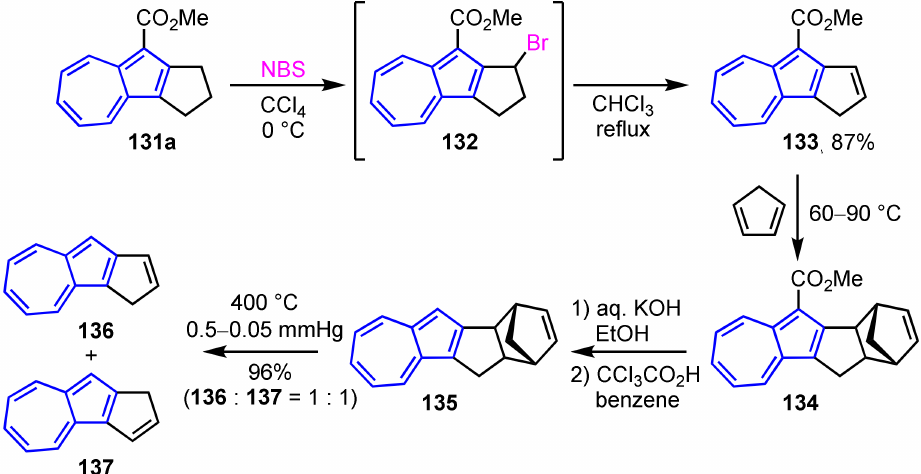
Scheme 33. Synthesis of cyclopent[ a ]azulenes 136 and 137